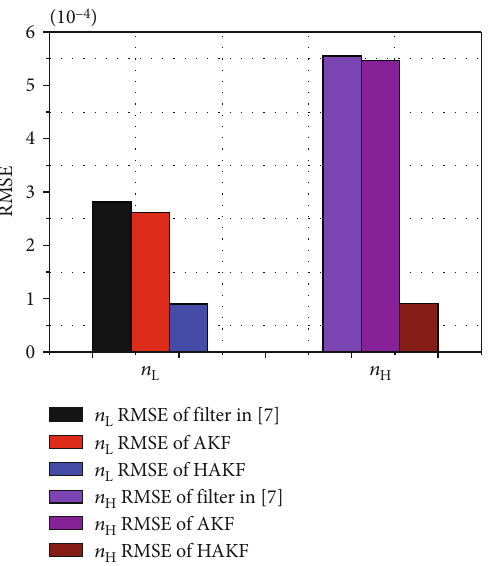
Figure 14: RMSEs of three estimation methods.